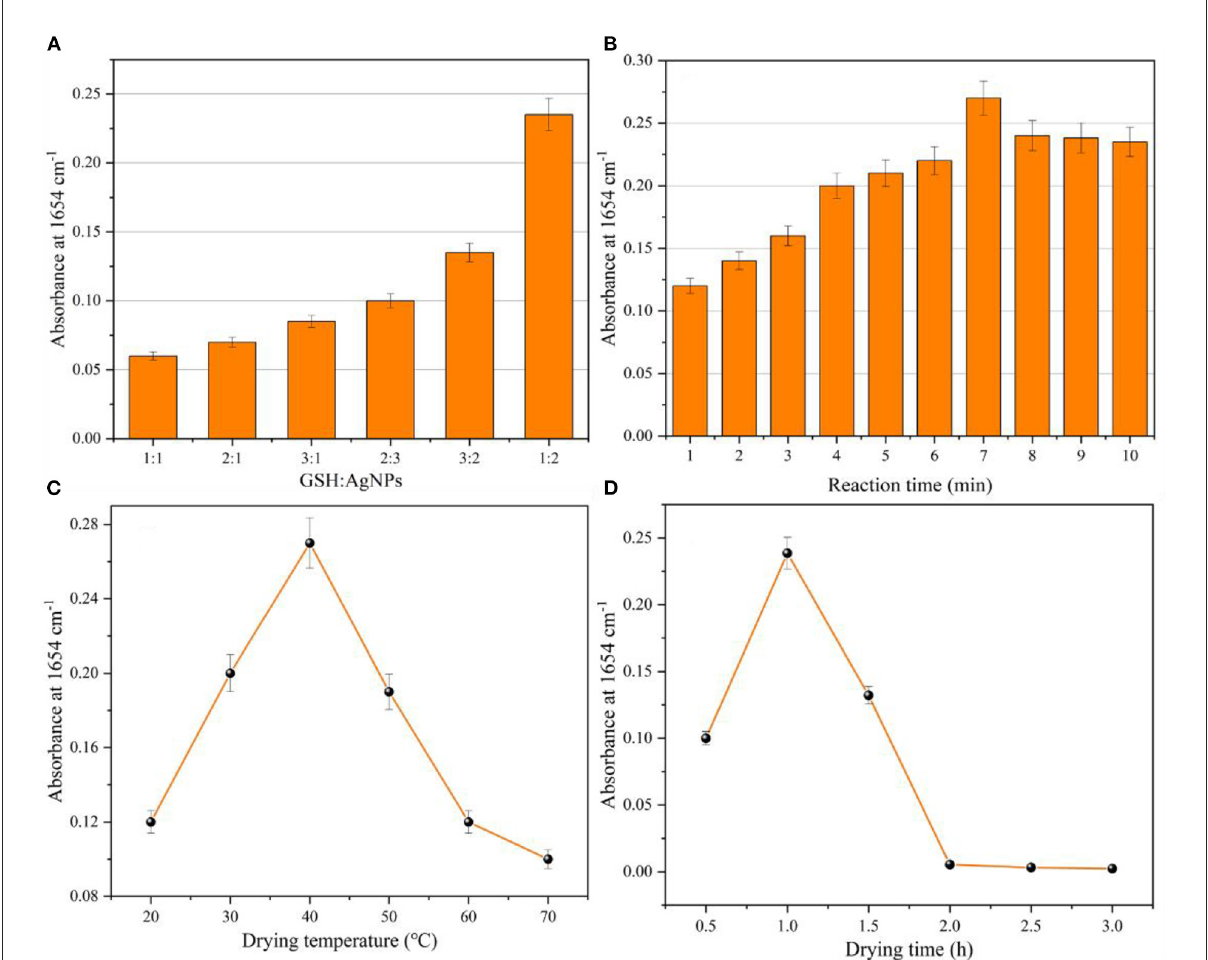
FIGURE6 Optimization parameters: (A) mixing ratio of glutathione and AgNPs; (B) mixing reaction time of glutathione and AgNPs; (C) drying temperature of CaF 2 window sheet; (D) drying time of CaF 2 window